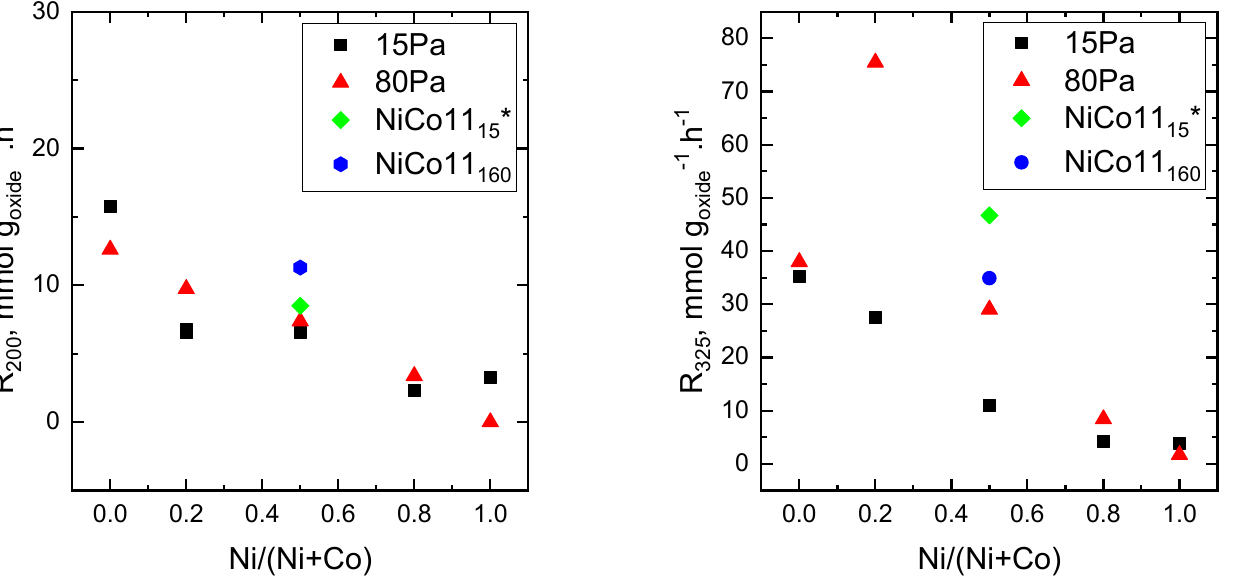
Figure 6. Dependence of specific reaction rates ( R 200 ) for ethanol oxidation and R 325 for toluene oxidation on molar Ni/(Ni + Co) ratio for the catalysts prepared at 15 and 80 Pa and two NiCo11 catalysts prepared under different conditions.